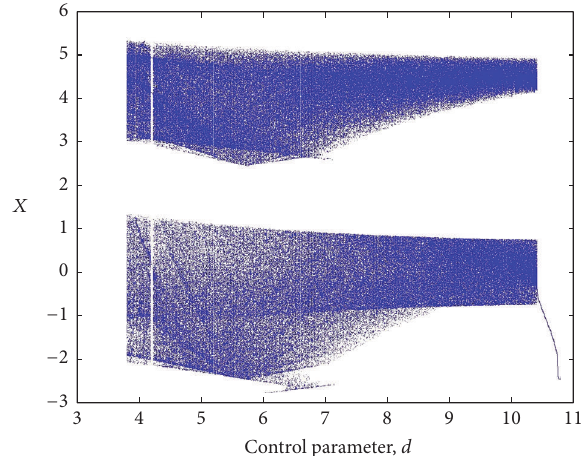
Figure 11: Bifurcation diagram using 𝑑 as control parameter. Parameters: {𝑎 = 20 , 𝑏 = 2 , and 𝑐 = 3} .